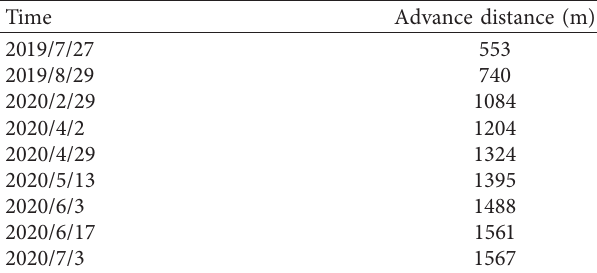
Table 6: Survey time and the corresponding face advance